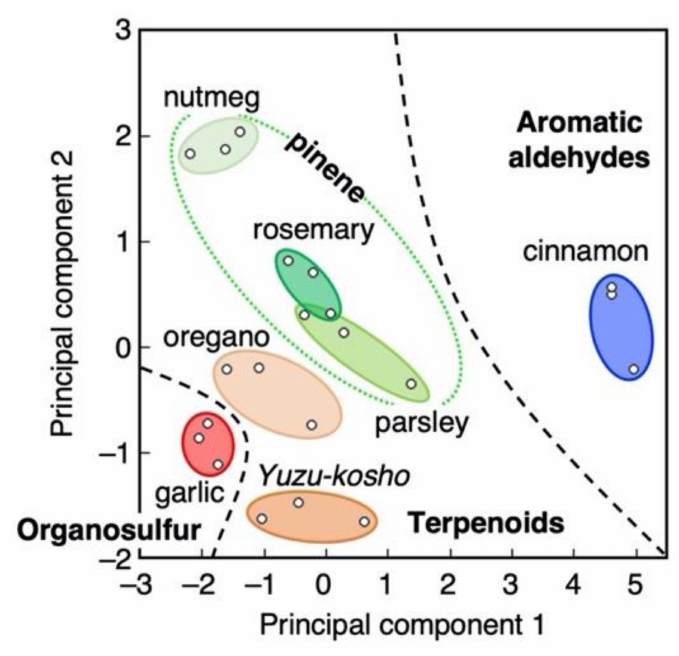
Figure 12. PCA scatter plot for smell identification of spices and herbs by the MSS array. The spices and herbs are categorized into three groups reflecting their major components (i.e., organosulfur, terpenoids, and aromatic aldehydes). Green dotted circle indicates the pinene-containing spices and herbs. Reprinted and modified with permission from Ref. [144]. Copyright 2016, the Japan Society of Applied